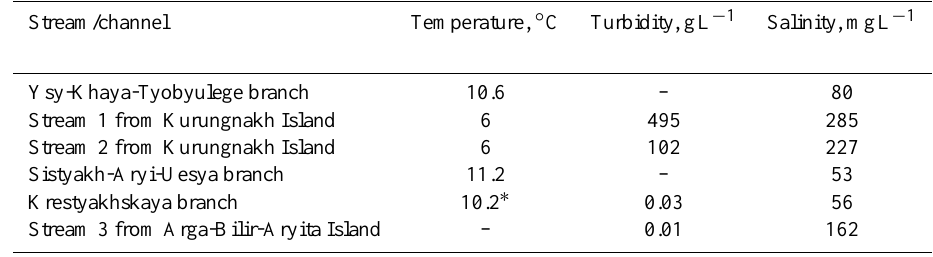
Table 4. Water salinity, turbidity, and temperature in the Lena River delta smaller branches and streams. Stream/channel Temperature, ◦ C